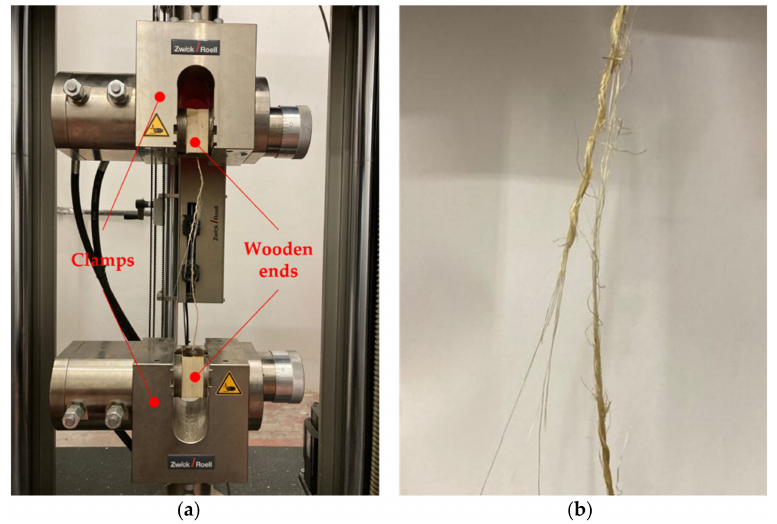
Figure 10. Setup of the tensile test of the strands carried out with the Zwick Roell machine under displacement control at the LPMS of L’Aquila. ( a ) The wooden ends protecting the strands by tearing due to the pressure of the clamps; ( b ) typical tensile failure of the strands.